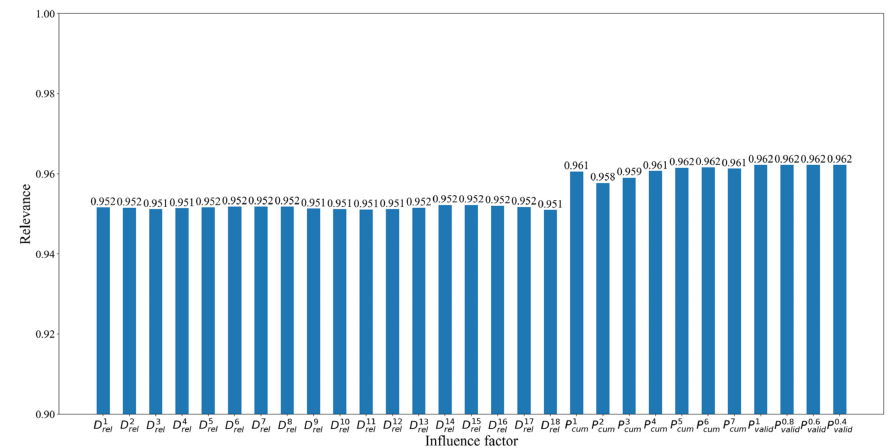
Figure 16. Results of gray correlation analysis for the Shangmao landslide.